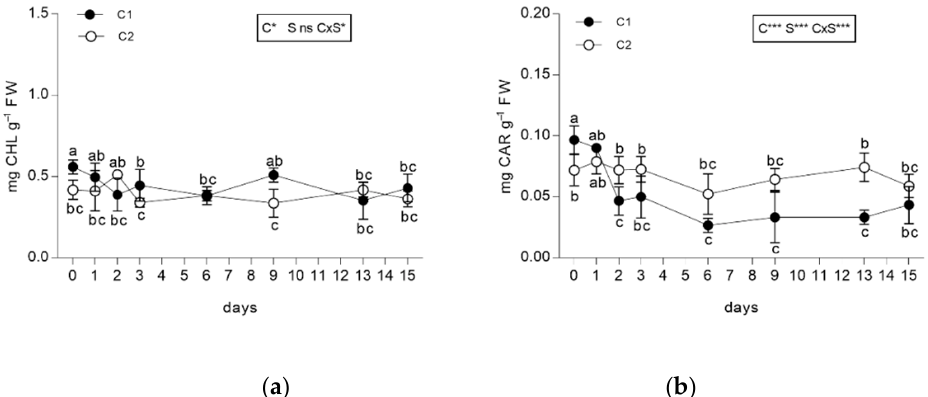
Figure 2. Chlorophyll content ( a ) and carotenoid content ( b ) of Rumex acetosa stored at 4 °C for 15 days as fresh-cut products. Closed and open symbols represent first (C1) and second harvests (C2), respectively. Each value is the mean (±SD) of three replicates. Means having the same letter are not significantly different at p = 0.05 following two-way ANOVA with storage (S) and cut (C) as variables. F values for main effects and their interaction significant at p < 0.05 (*); p < 0.001 (***), or not significant (ns). Chlorophyll (CHL) and carotenoid (CAR) content values were both expressed as mg g –1 FW.